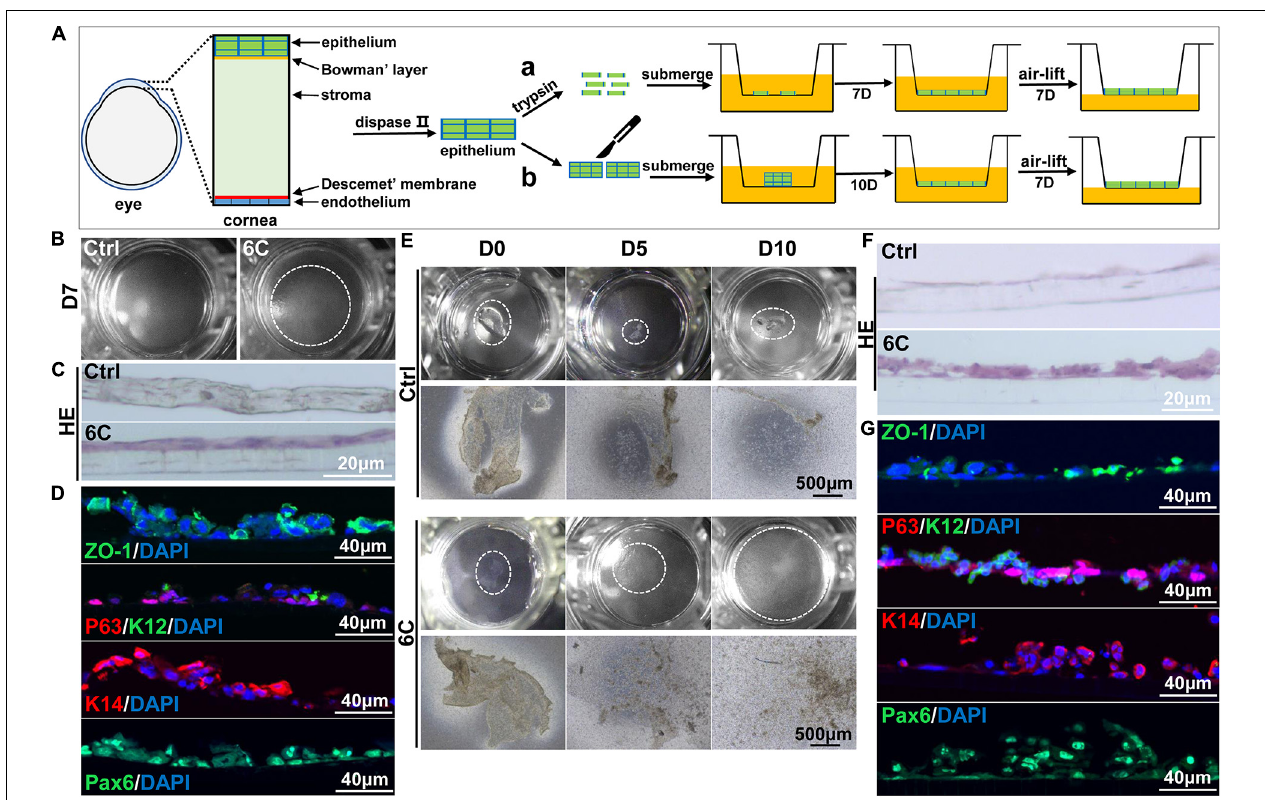
FIGURE 7 | 6C helps to construct tissue engineered mouse corneal epithelium. (A) Schematic diagram of tissue engineering mouse corneal epithelial sheet culture. (a) The isolated mouse corneal epithelium was digested into single cells with trypsin, and then planted into insert. After the cells were confluent, they were cultured in air exposure. (b) Divide the isolated corneal epithelium into two and plant it on 12-well cell culture inserts. After the cells are covered with the insert, do air exposure culture. (B) When epithelial single cells were cultured to the seventh day, the cells in the 6C treatment group were almost confluent. (C) HE staining results of mCEC after air exposure culture. The cells in the 6C treatment group were stratified to two layers. (D) Immunofluorescence staining of Z0-1 (green), P63 (red), K12 (green), K14 (red) and Pax6 (green). Nuclei were stained with DAPI (blue). (E) Morphological comparison of corneal epithelial sheets cultured with corneal epithelium. In the 6C treatment group, during the culture of the epithelial sheet, the epithelial cells crawled out from the edge, and the surface cells gradually fell off. By the tenth day of culture, the cells were almost confluent, but the epithelium of the control group hardly grew. (F) HE staining results of corneal epithelium after air exposure. (G) Immunofluorescence staining of Z0-1 (green), P63 (red), K12 (green), K14 (red) and Pax6 (green). Nuclei were stained with DAPI (blue).